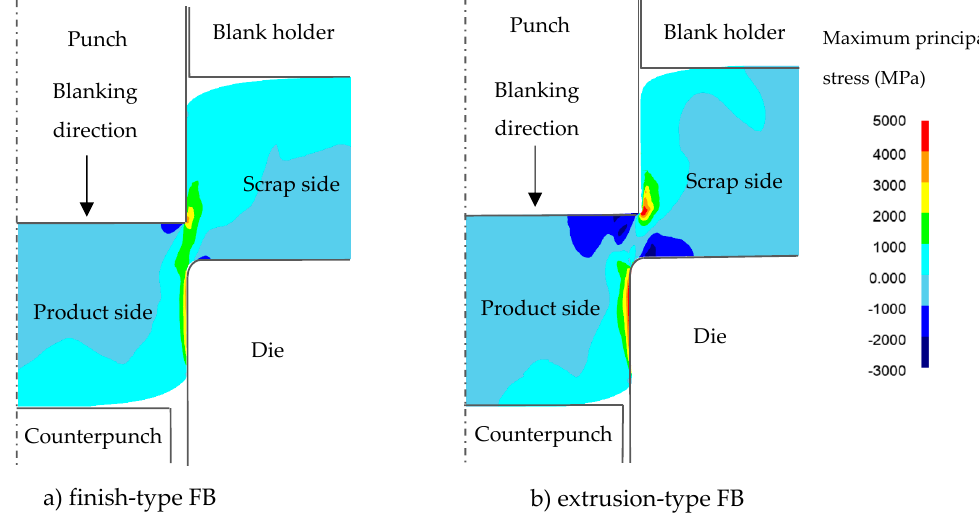
Figure 6. Comparison of maximum principal stress for 80% t punch penetration between the finish-type FB and extrusion-type FB in Figure 4: ( a ) finish-type FB; ( b ) extrusion-type